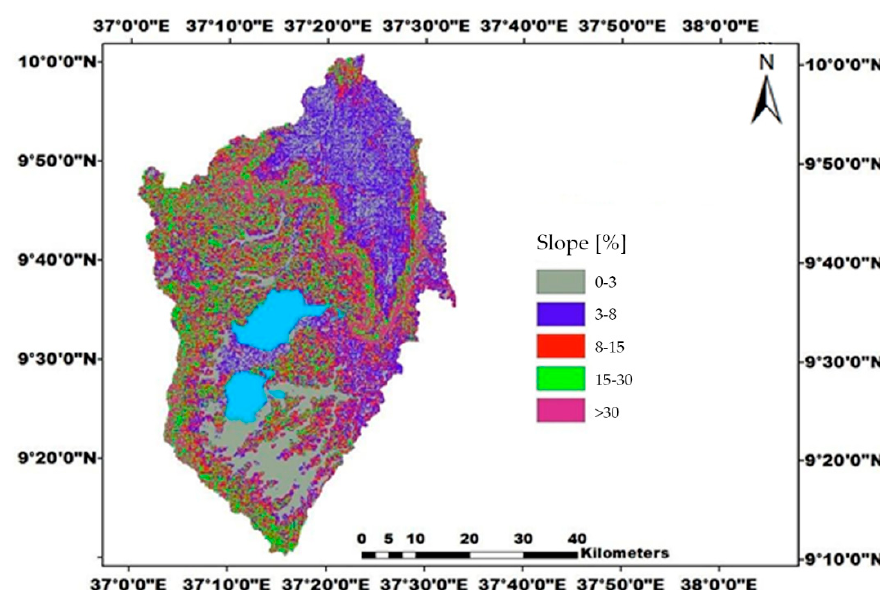
Figure 8. Slope classes in the Fincha’a watershed.